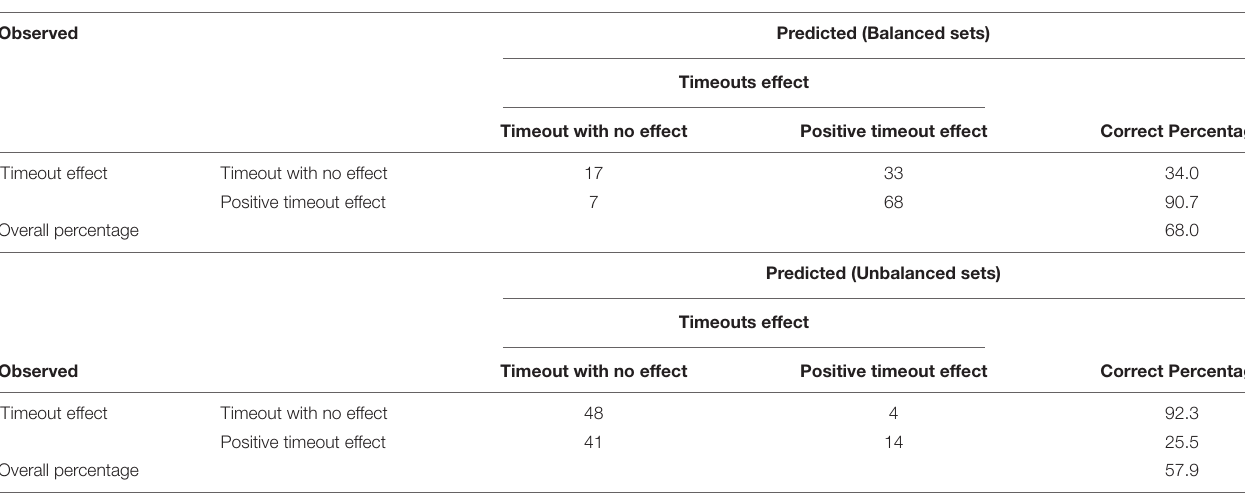
TABLE 6 | Classification table (balanced sets and unbalanced